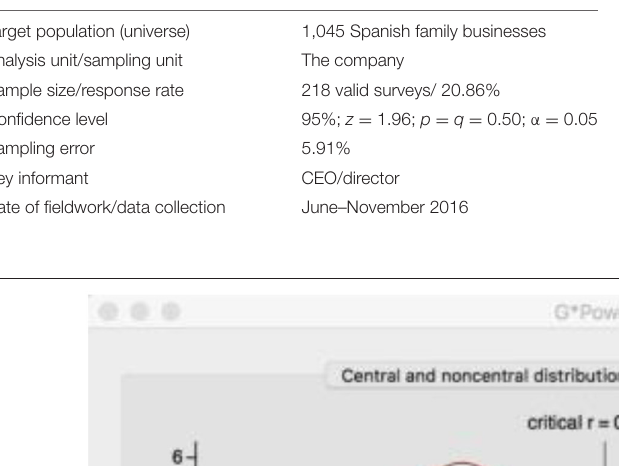
TABLE 1 | Overview of the fieldwork.